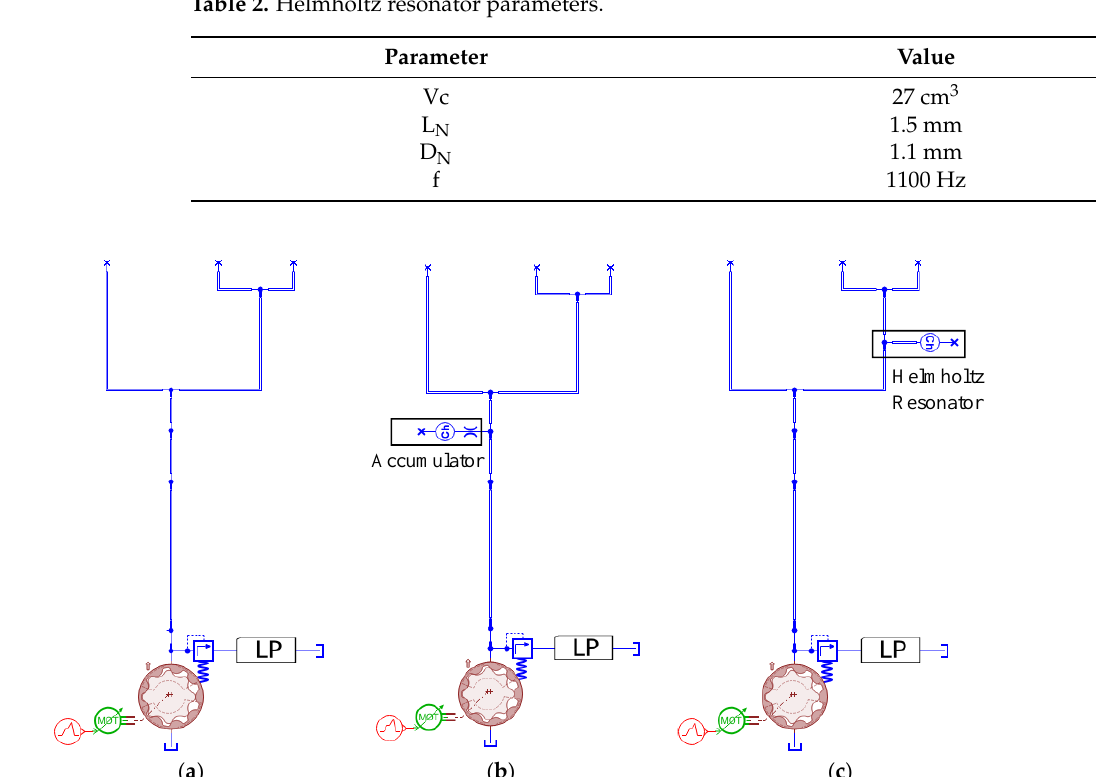
Figure 7. Modified models: ( a ) with 19 teeth Gerotor pump; ( b ) with the accumulator; ( c ) with the Helmholtz resonator.